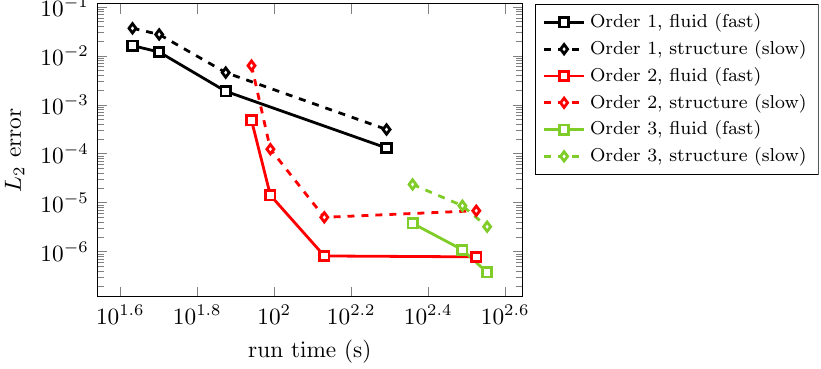
Figure 10. Error vs. CPU time for first, second and third order MGARK scheme applied to the moving piston test